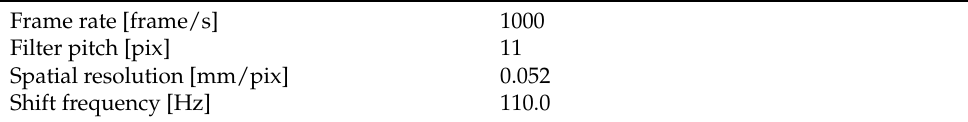
Table 3. Parameters of SFV for aneurysm model.